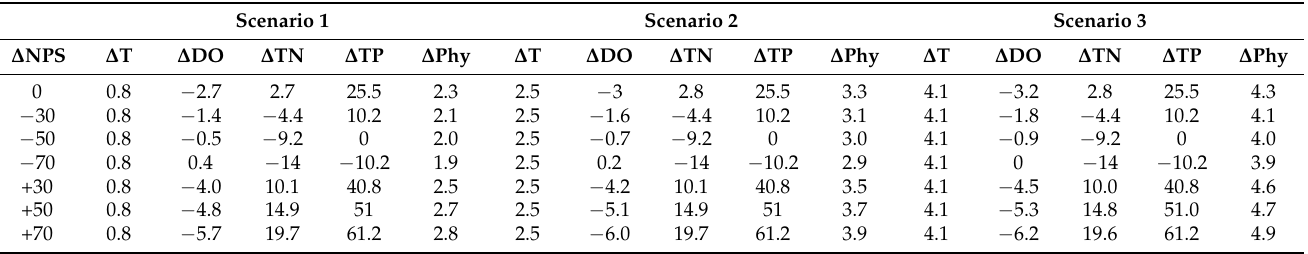
Table 6. Percentage changes in water temperature (T), DO, TN, and TP, and phytoplankton (Phy) concentrations under the water quality improvement scenarios for the Shoalhaven River